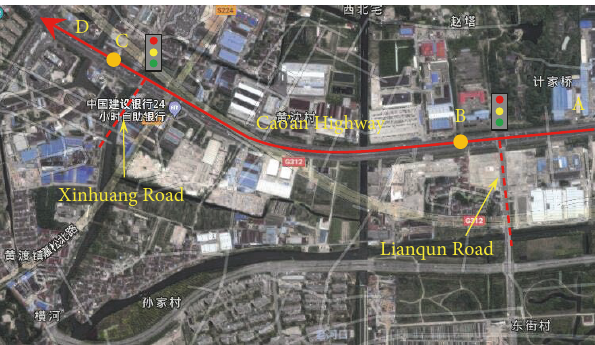
Figure 4: Test bed